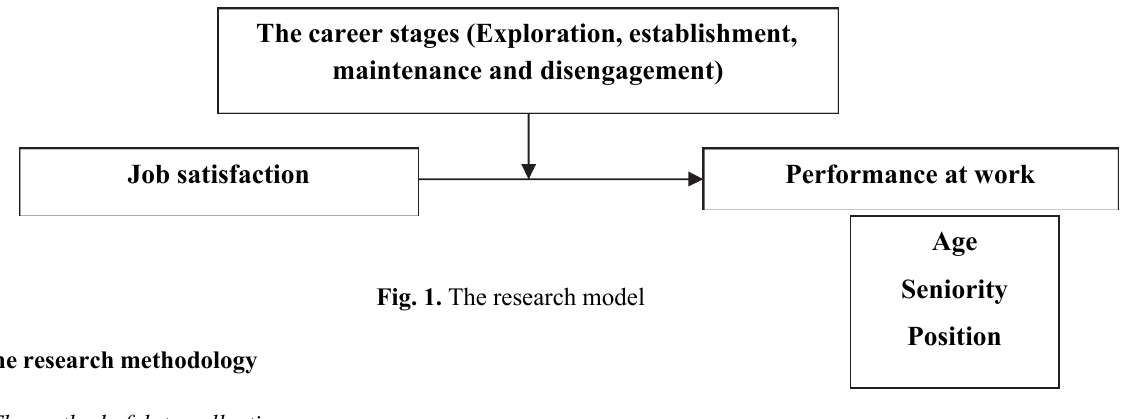
Fig. 1. The research